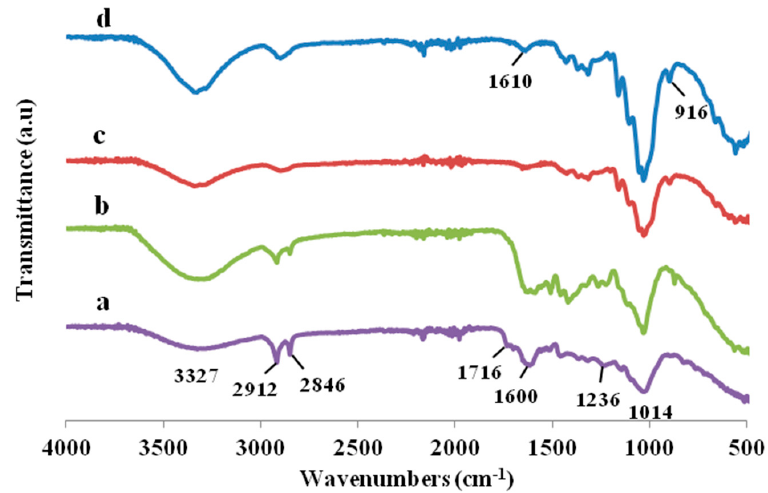
Figure 2. FTIR spectra of (a) raw TLWF; (b) alkaline-treated TLWF; (c) bleached TLWF; and (d) cellulose nanocrystals (CNC). nanocrystals